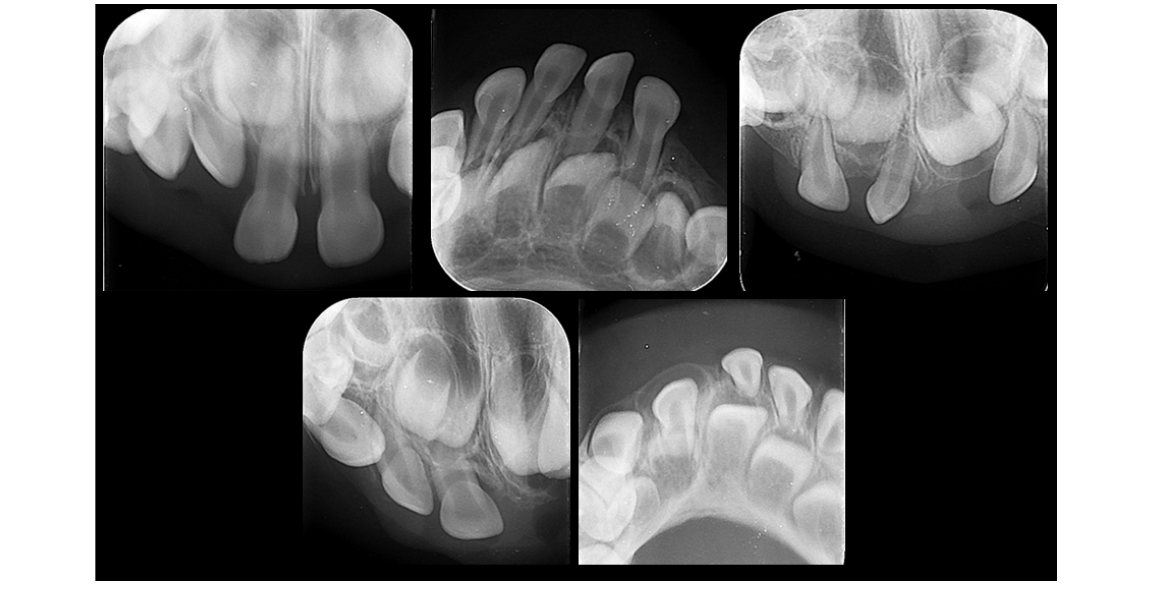
Figure 3. Dental anomalies of number.